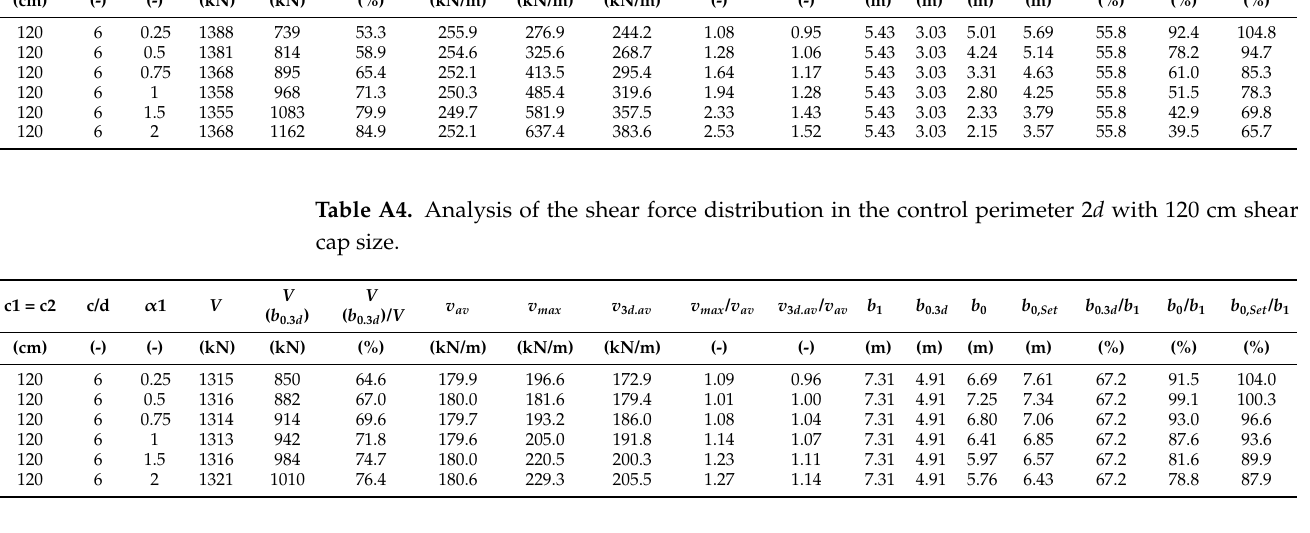
Table A5. Analysis of the shear force distribution in the control perimeter 0.5 d with 160 cm shear cap size.